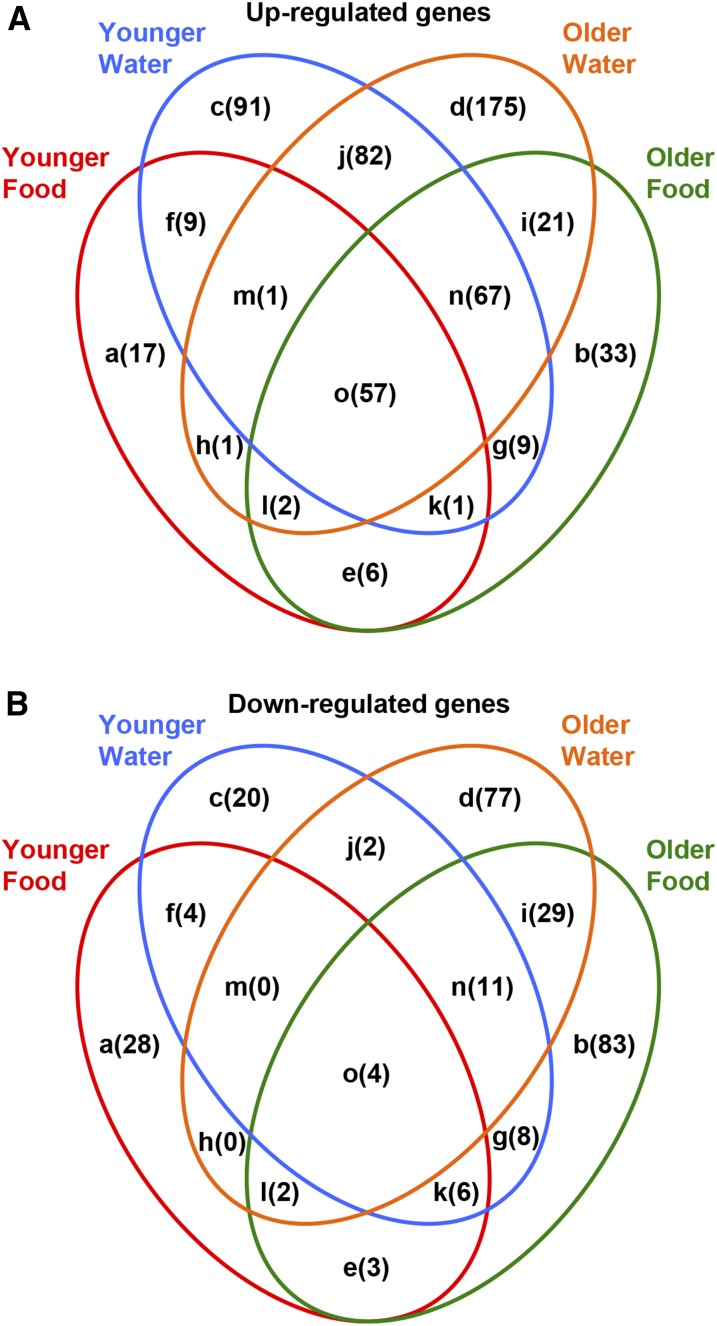
Overview of significant changes in gene expression after primary injuries in w1118 flies, as determined by RNA-seq at 2 hr postinjury for flies fed water and 4 hr postinjury for flies fed food. Indicated in parentheses is the number of genes whose expression was (A) up-regulated or (B) down-regulated more than twofold, with an FDR P < 0.05, following primary injuries among the four indicated conditions. Lowercase letter designations correspond to Table S2 and Table S3, which list up-regulated and down-regulated genes, respectively. Table 2 contains the complete list of up-regulated and down-regulated genes that were common to all four conditions, and Table 3 contains a partial list of innate immune response genes that were common to a subset of conditions.